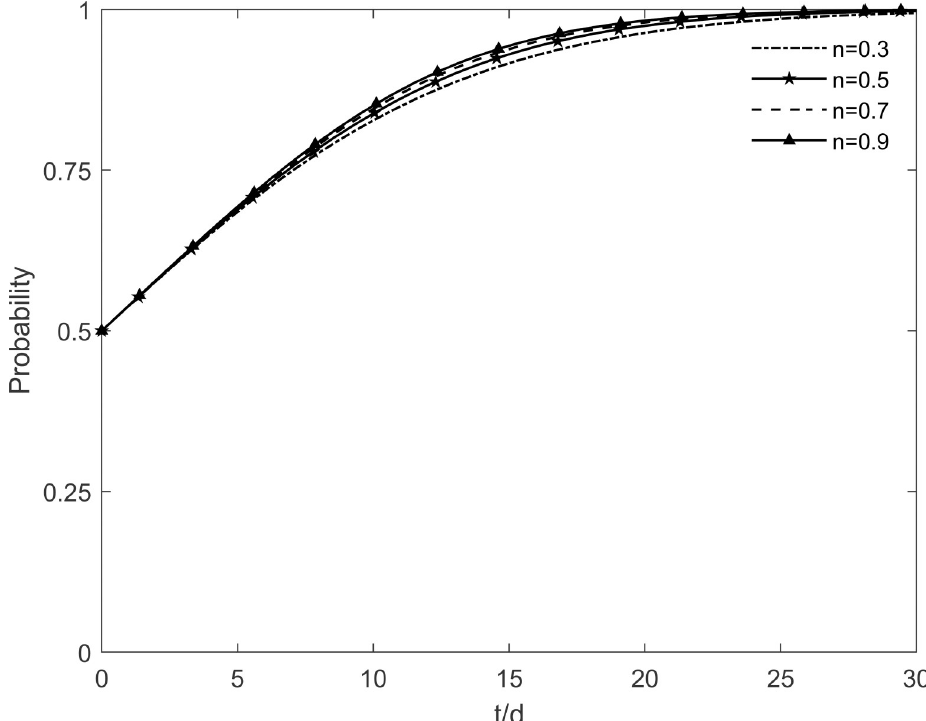
Fig 14. The impact of n on residents’ strategic choices.